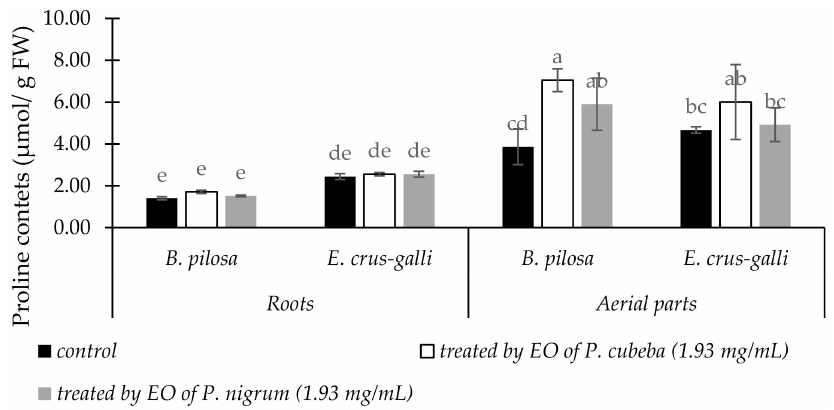
Figure 6. The changes of proline in the roots and aerial parts of between treated and untreated B. pilosa and E. crus-galli by P. cubeba and P. nigrum EOs. Data were presented in means ± standard deviations (SD). Means with di ff erent small letter indicted significantly di ff erent by Fisher’s test ( p <